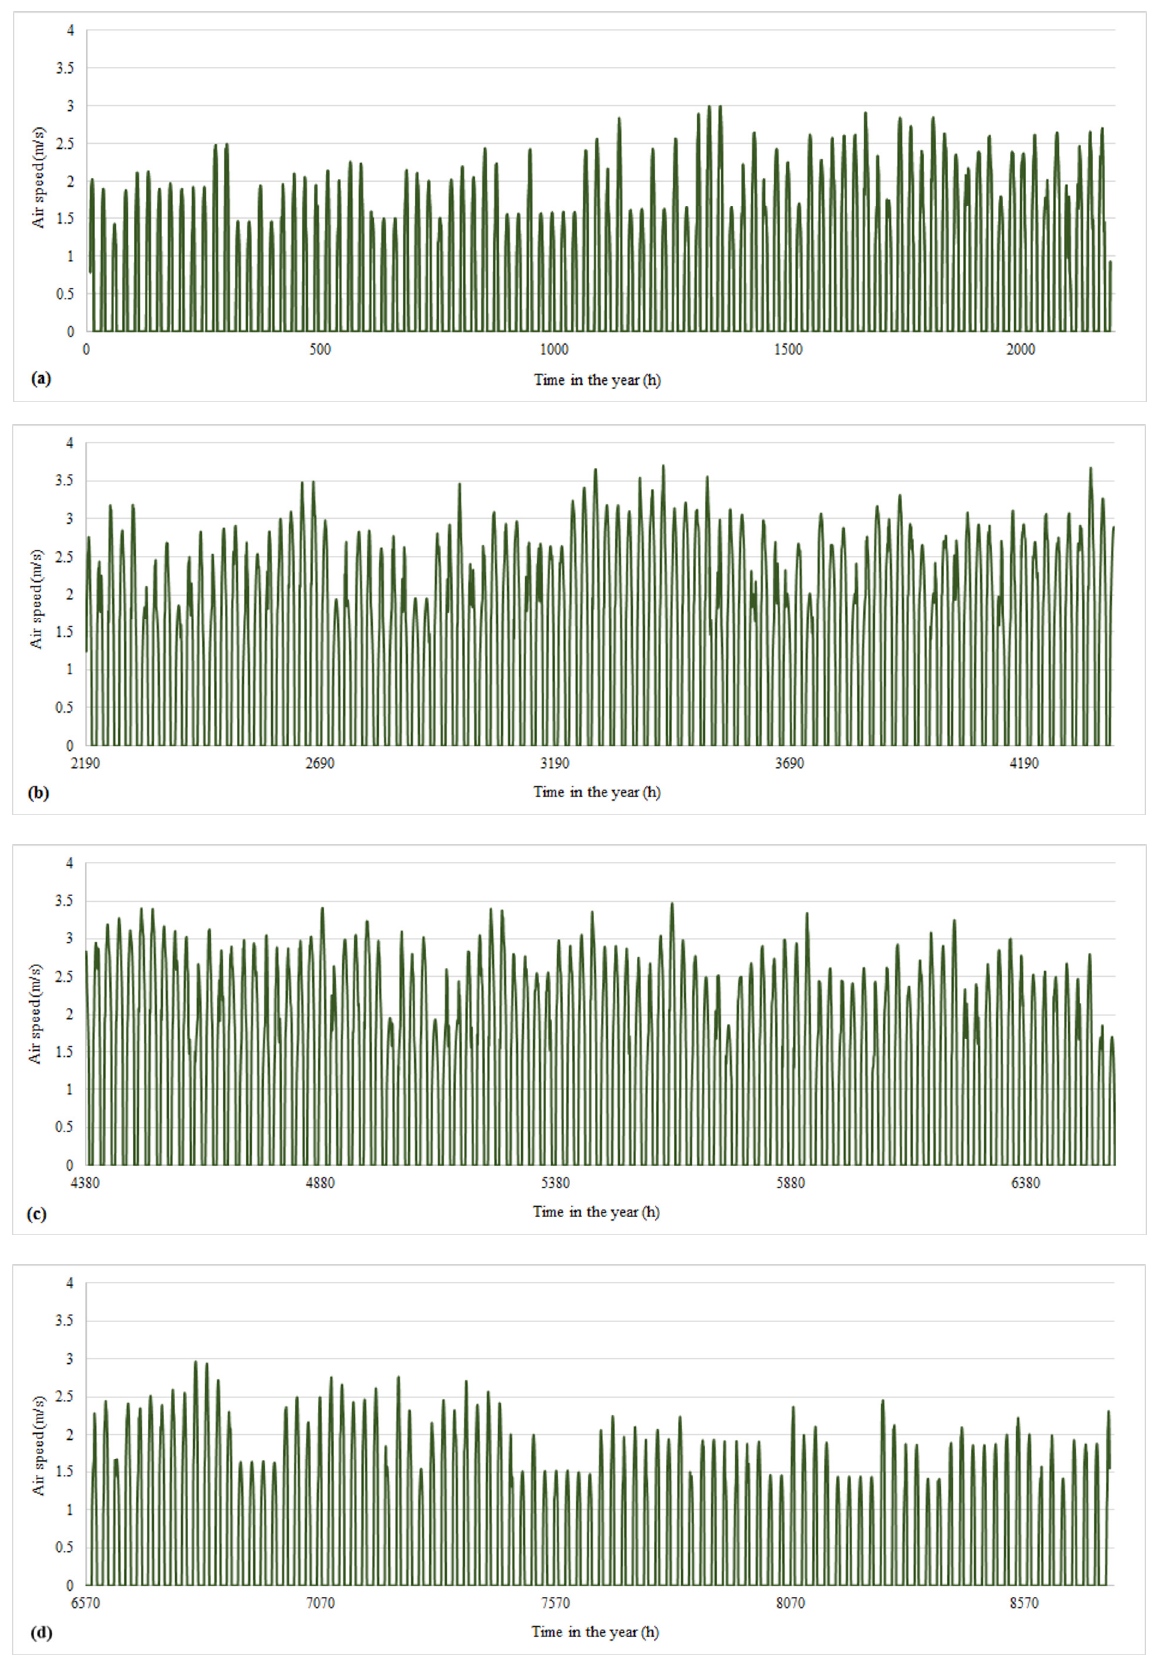
Figure 5. ( a – d ). Air speed in the solar chimney in each quarter of the year. The average air velocity in the first quarter is 1.68 m/s; when the air velocity is in the range of 2.00–3.00 m/s, it has a frequency of 29.65%; when the air velocity is in the range of 1.00–1.99 m/s, it has a frequency of 57.97%; when the air velocity is in the range of 0.28– 0.99 m/s, it has a frequency of 12.38%. The average air velocity in the second quarter is 2.17 m/s; when the air velocity is in the range of 3.00–3.70 m/s, it has a frequency of 9.86%; when the air velocity is in the range of 2.00–2.99 m/s, it has a frequency of 48.31%; when the air velocity is in the range of 1.00–1.99 m/s, it has a frequency 36.21%; when the air velocity is in the range of 0.30–0.99 m/s, it has a frequency 5.62%. The average air velocity in the third quarter is 2.14 m/s; when the air velocity is in the range of 3.00–3.47 m/s, it has a frequency of 7.25%; when the air velocity is in the range of 2.00–2.99 m/s, it has a fre- quency of 51.46%; when the air velocity is in the range of 1.00–1.99 m/s, it has a frequency of 36.13%; when the air velocity is in the range 0.30–0.99 m/s, it has a frequency of 5.16%. The average air speed in the fourth quarter is 1.61 m/s; when the air velocity is in the range